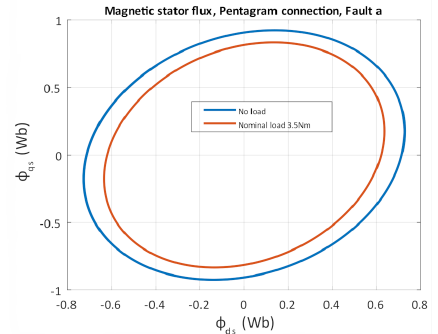
Figure 22. Magnetic stator flux, pentagon connection, fault phase a.